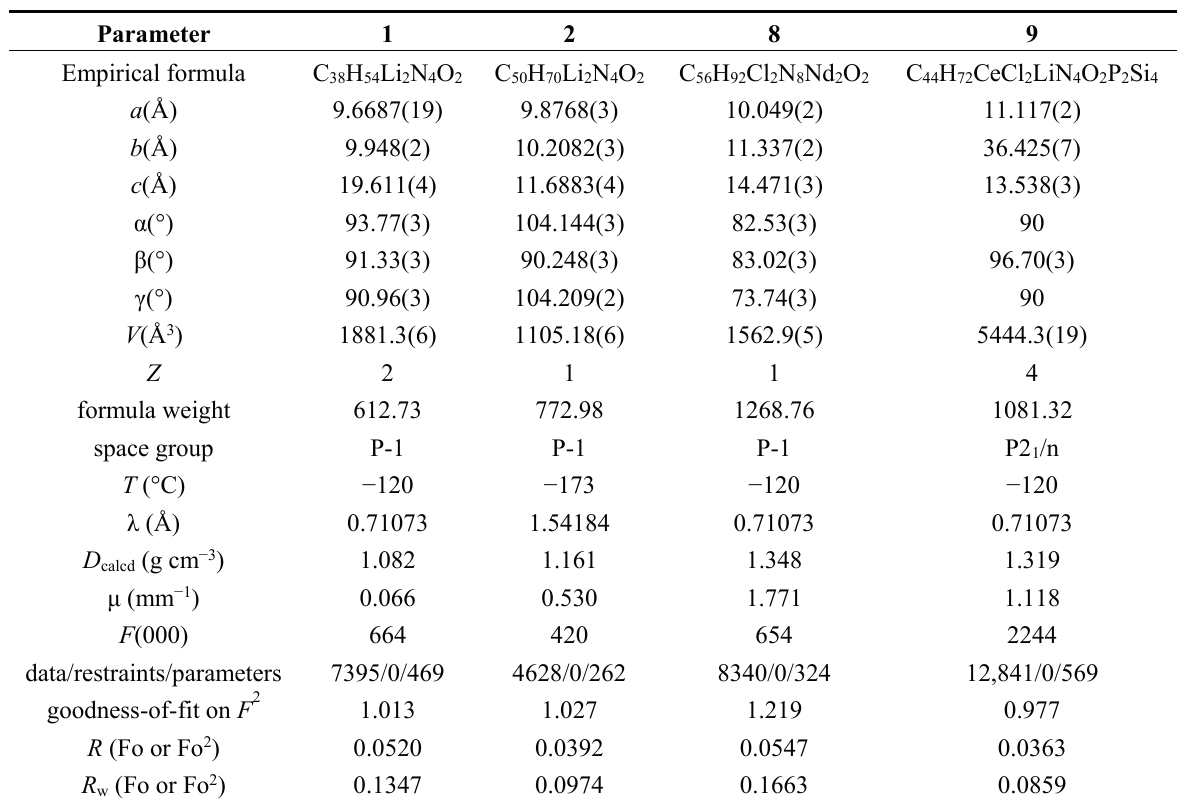
Table 1. Crystallographic Data for 1 , 2 , 8 and 9